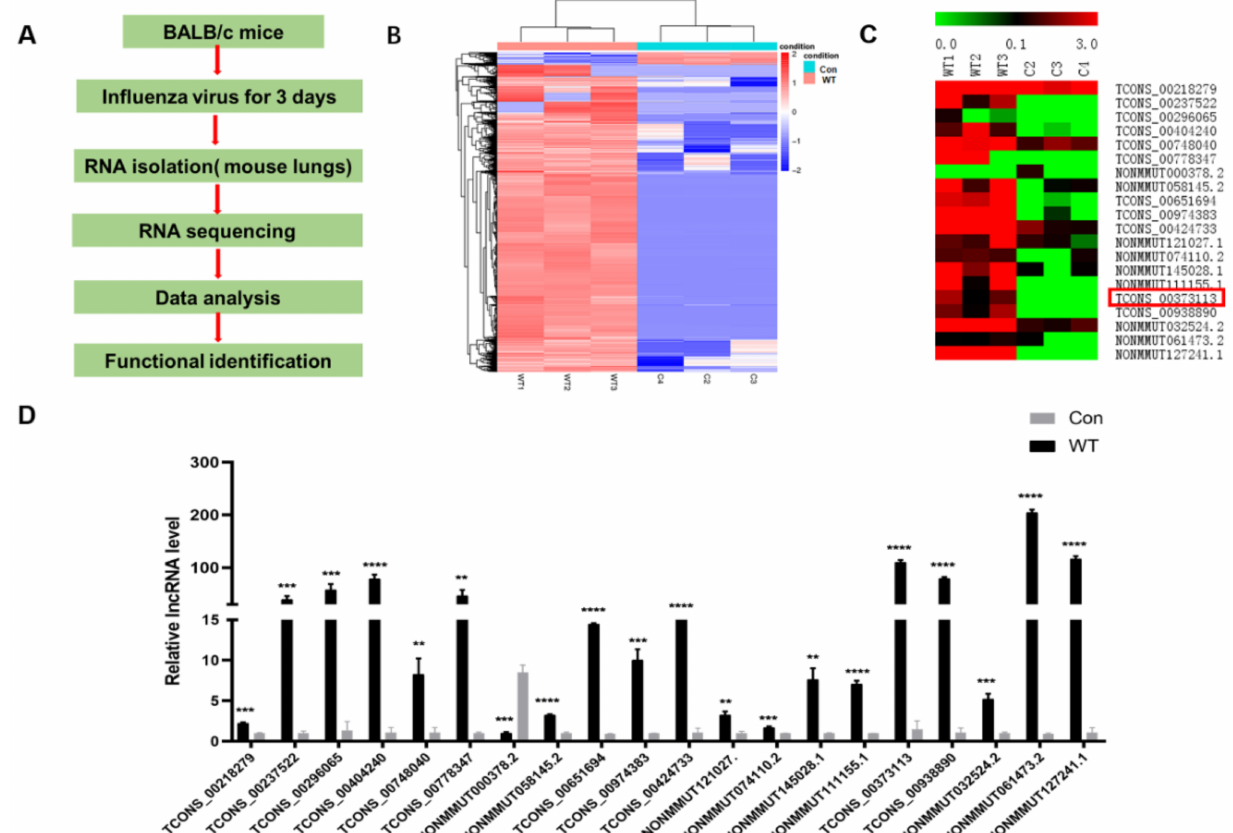
Figure 1. Different regulated lncRNAs after influenza virus infection. ( A ) Schematic description of the RNA-seq experimental design. ( B ) Analysis of RNA sequencing of mouse with IAV infection and after recovery revealed 7045 upregulated and 981 downregulated lncRNAs ( p < 0.05, fold change > 2). ( C ) 20 lncRNAs are selected and shown in heat maps. ( D ) The relative levels of selected lncRNAs in the infected mouse were examined by RT-qPCR ( n = 3; means and SD; ** p < 0.01 *** p < 0.001, **** p <